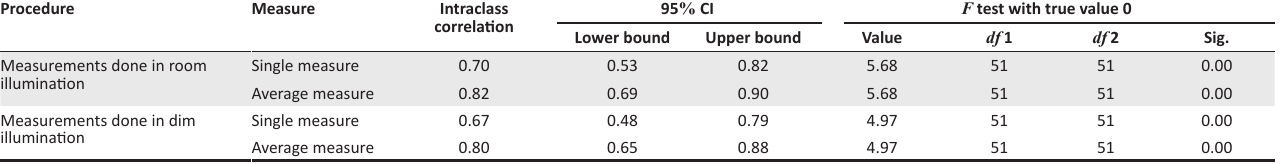
TABLE 3: Results of intraclass correlation coefficient calculations in Statistical Package for Social Sciences using a two-way mixed model and consistency.